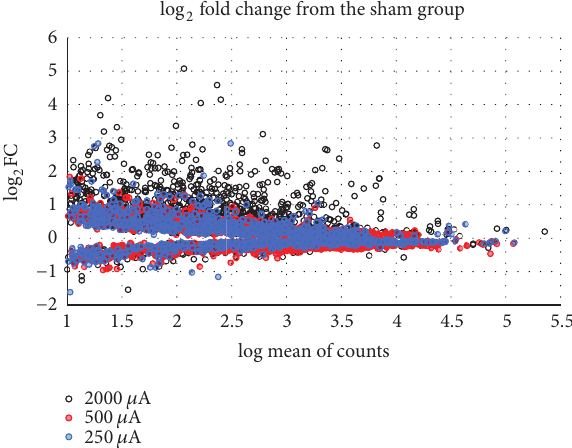
Figure 1: Comparison of genes altered by various tDCS intensities. For this plot, DESeq countable data was used to calculate log 10 mean of counts and log 2 fold change. The 𝑥 -axis is log 10 mean of counts and the 𝑦 -axis is log 2 fold change from sham group. For this plot, the genes with an expression level ≥ 10 counts and 𝑝 value (one-tailed 𝑡 - testbetweeneachtDCSandshamgroup)lessthan0.05wereselected to draw the plot. The greater distance from 0 log 2 FC represents a larger change in gene expression levels from